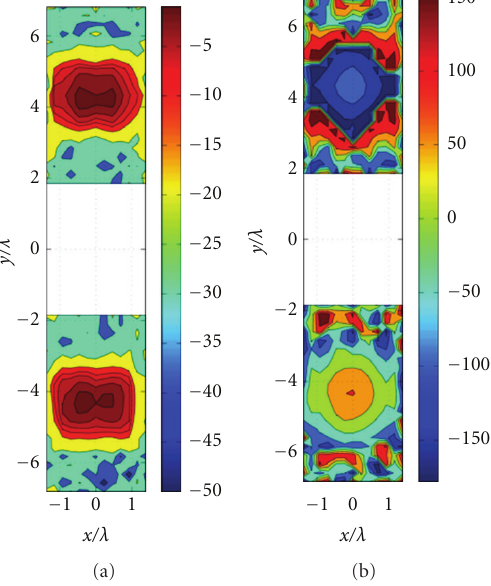
Figure 19: Dual horn, horizontal polarization, di ff erence pattern. (a) amplitude of the aperture field distribution. (b) phase of the aperture field distribution.